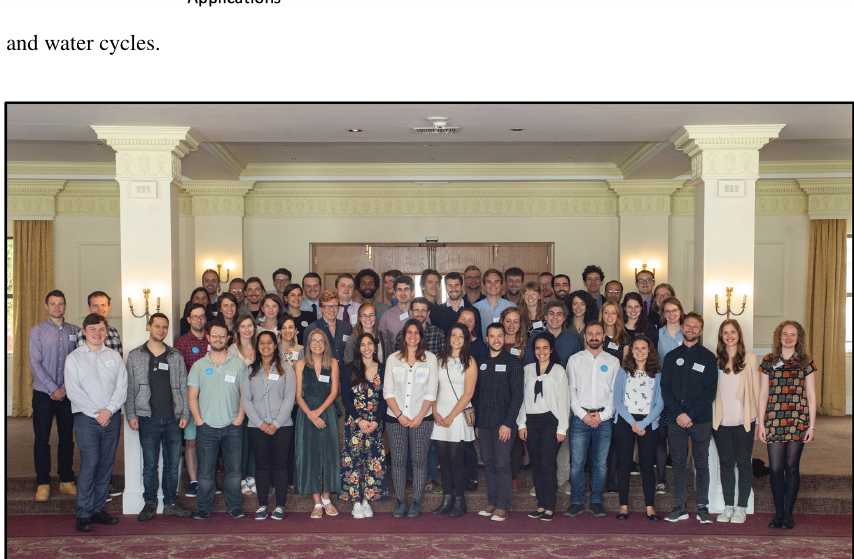
Figure 2. WISE CDT PhD students (summer school in Torquay, UK, 2019; photo credit © Steven Haywood